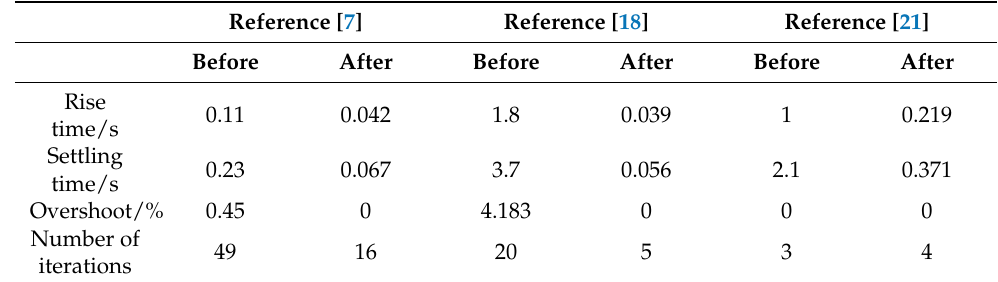
Figure 4. Response curves of different references after G-PSO algorithm optimization: ( a ) Refer- ence [7], ( b ) Reference [18], ( c ) Reference [21]. Table 3. Comparison table of system performance parameters before and after G-PSO algorithm opti- mization.